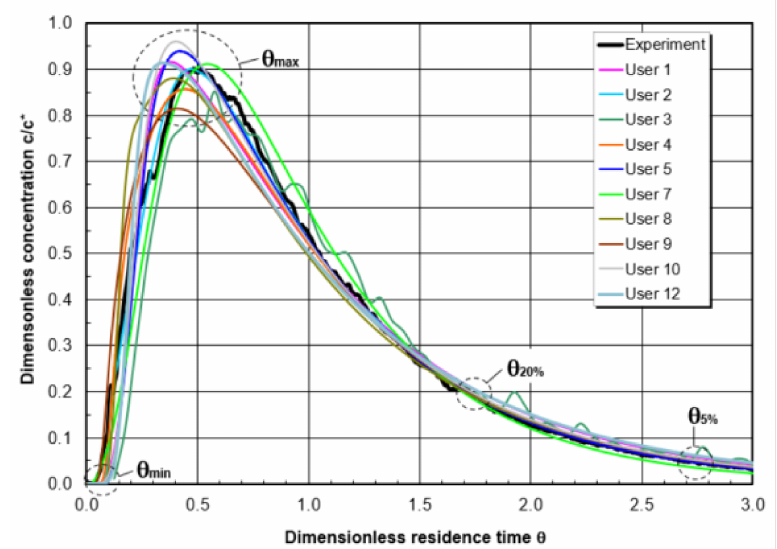
Figure 17. RTD curves among users.